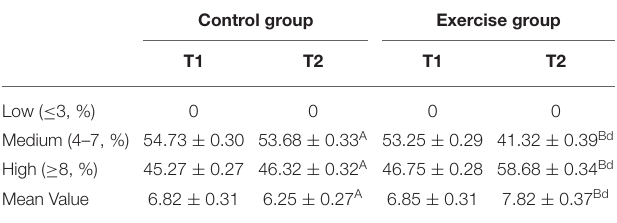
TABLE 2 | Results of the KIDMED test evaluating the adherence to the Mediterranean diet from the control and exercise groups.